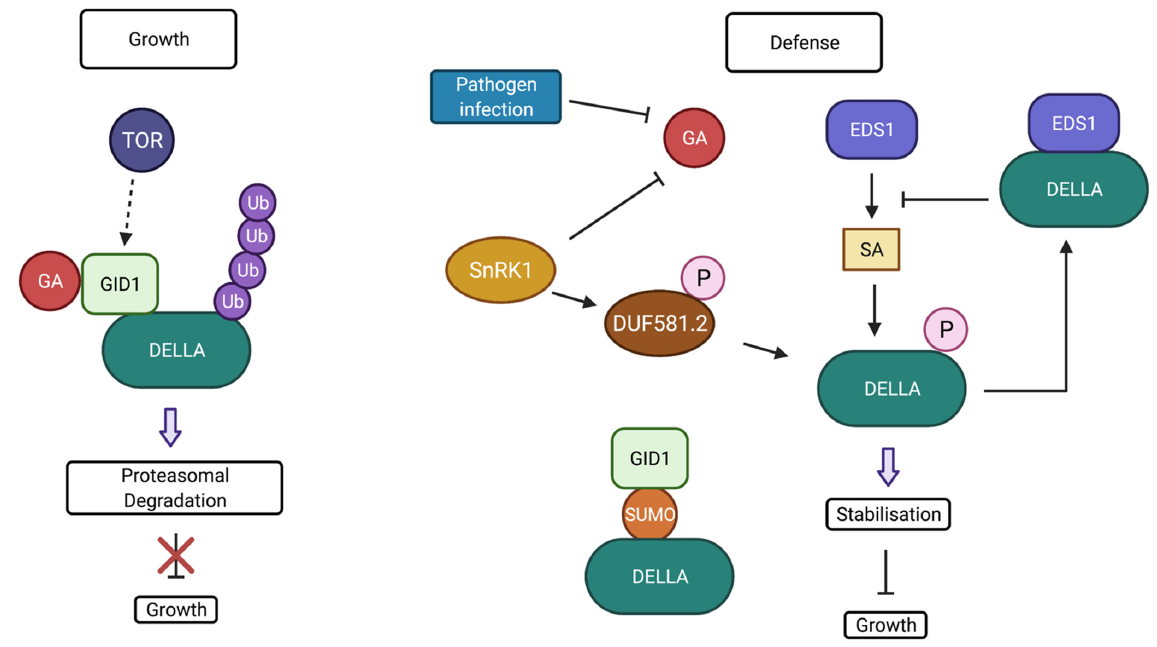
Figure 4. DELLA interactions with PTMs in growth and defence. When gibberellic acid (GA) accumulates, it binds to GA INSENSITIVE DWARF1 (GID1) which then binds to DELLA, triggering DELLA ubiquitination and proteasomal degradation and allowing GA-responsive gene expression and growth. DELLA is stabilised in various ways to promote defence and restrict growth. In defence, GA levels are reduced which reduces GA-mediated DELLA degradation. DELLA is stabilised by phosphorylation. Independent of GA, DELLA is stabilised by SUMOylation which blocks GID1 degradation on unSUMOylated DELLA. SnRK stabilises DELLA through intermediate protein DUF581-2. DELLA forms a negative feedback loop to control SA accumulation. P, phosphate group. S, SUMO. Ub, Ubiquitin. Solid lines indicate direct interactions; dashed line indicates suggested positive interaction.